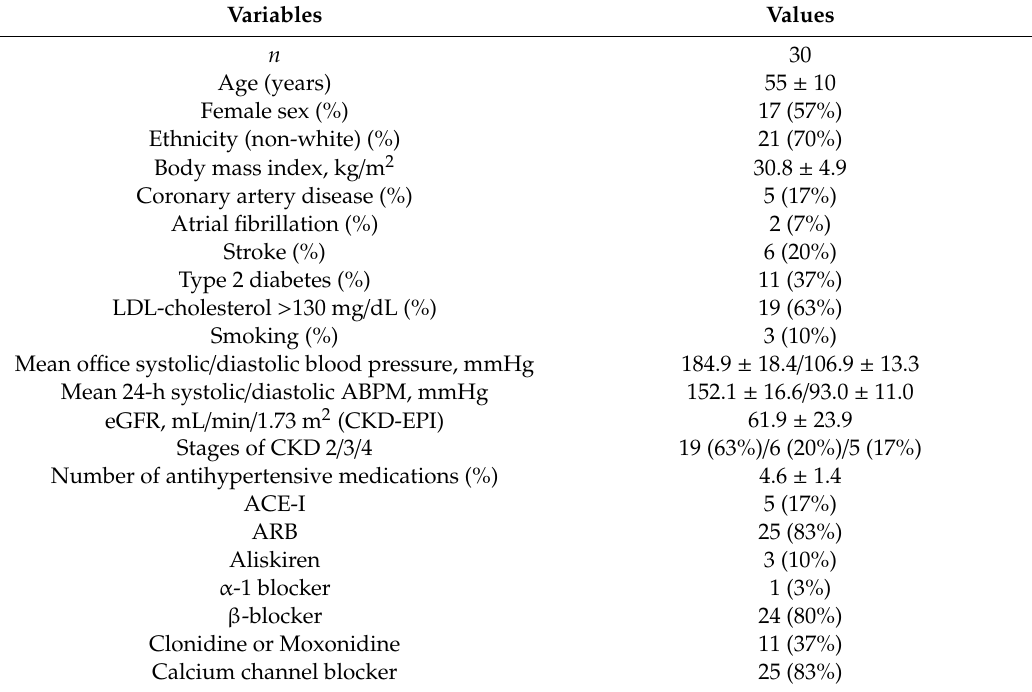
Table 1. General features of patients at